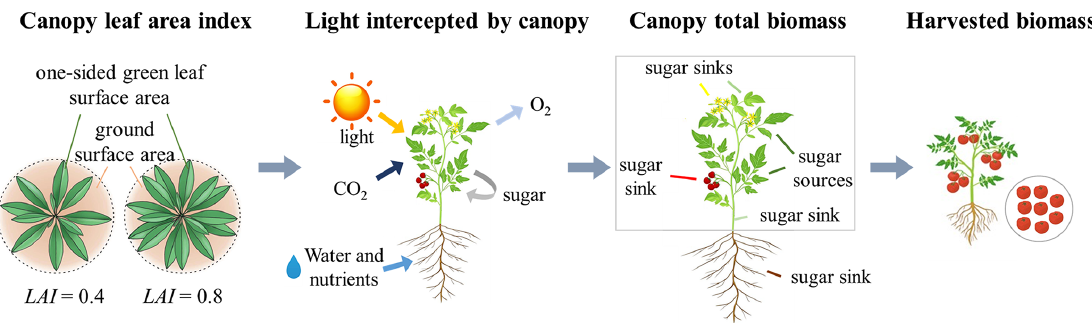
Figure 4. Illustration conceptualising the relationships between the canopy leaf area index (LAI), light interception by canopy, canopy total biomass, and harvested biomass.